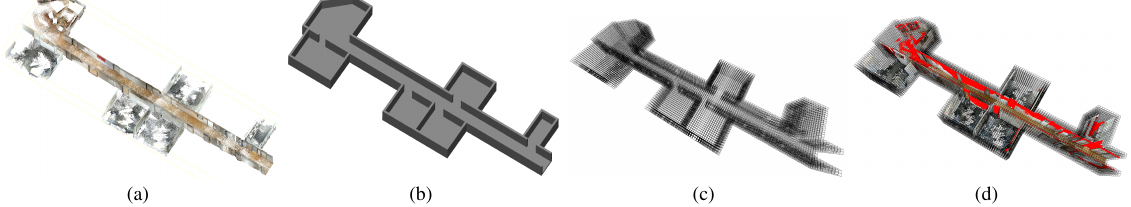
Figure 1. Example of point cloud and BIM geometry processing required for deviation analysis. (a) The captured indoor point cloud, (b) The extracted BIM geometry mesh, (c) The voxelized version of the BIM geometry mesh, and (d) Aligned point cloud with the voxelized BIM mesh, with spatial deviations highlighted in red.